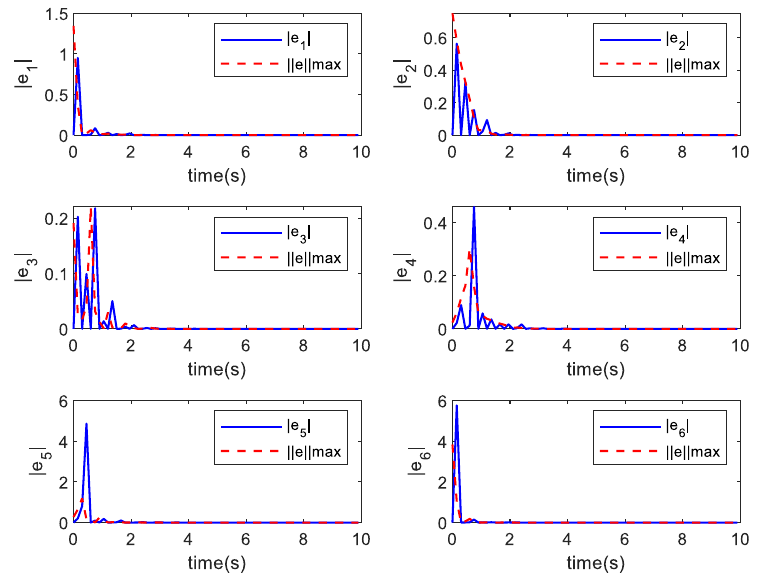
Figure 7. Control inputs for the agents.